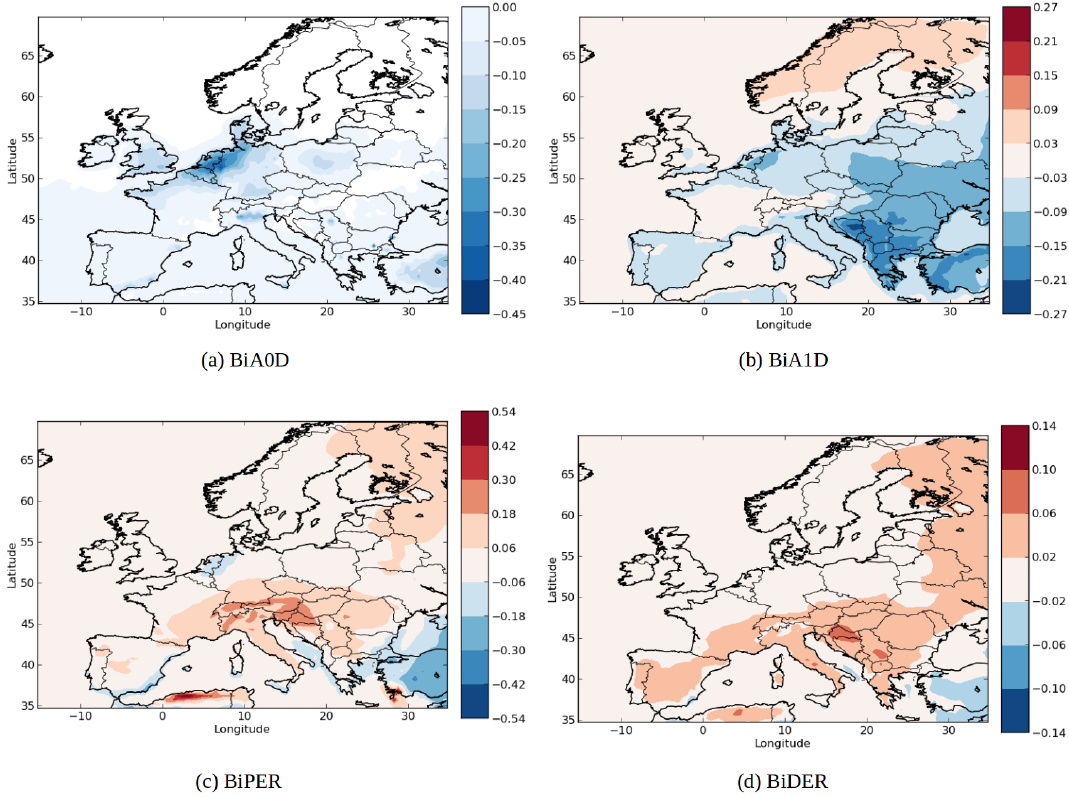
Figure 8. Differences in concentrations of several SOA compounds between AIOMFAC and UNIFAC over Europe (AIOMFAC – UNIFAC in µgm − 3 ). The definition of the compounds is given in Table